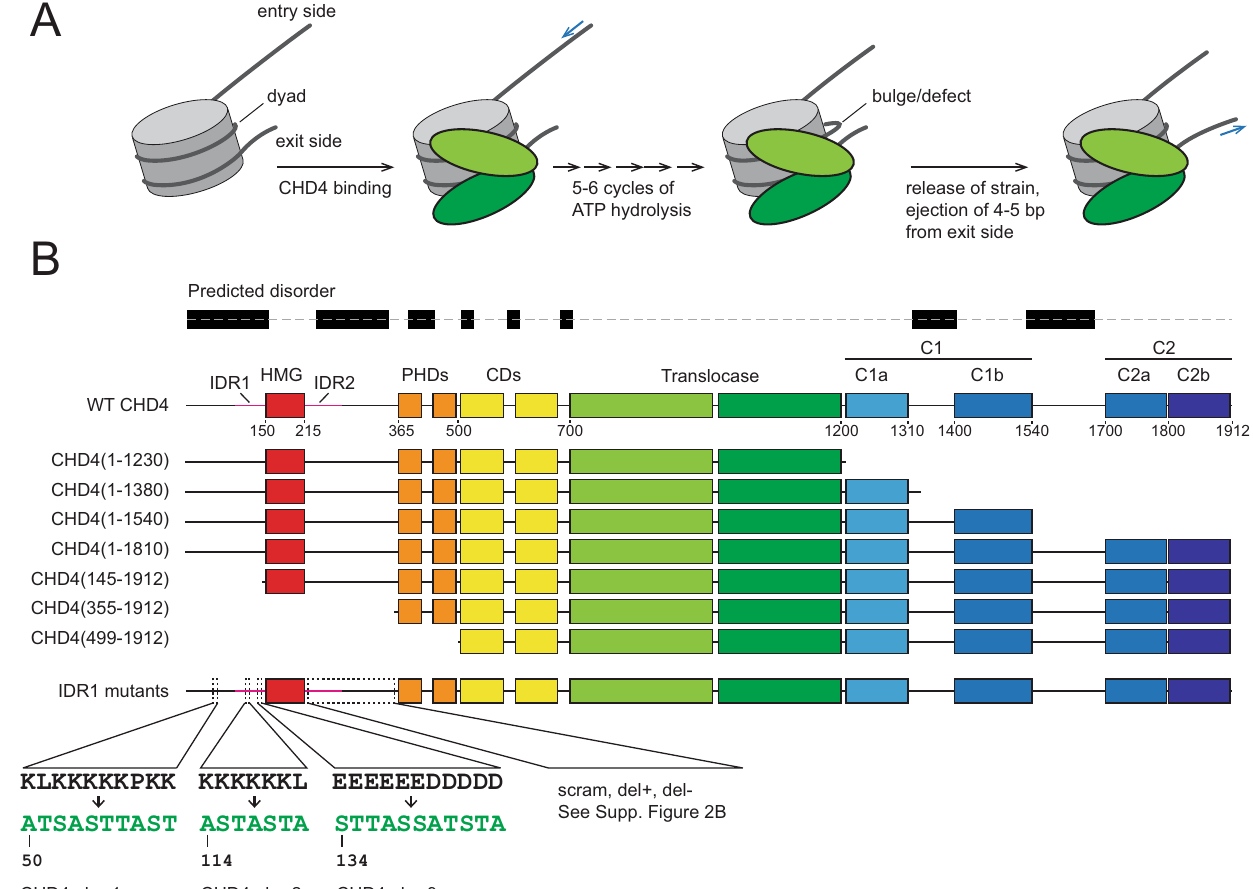
Fig. 1 | Model for CHD4-driven nucleosome sliding activity. A Model for CHD4- driven nucleosome sliding, based on previous work 4,19,80 . After initial binding of CHD4,multipleroundsofATPhydrolysisarecoupledto1-bptranslocationsofDNA from the entry side, building up a bulge or twist defect that incorporates the additionalbasepairs. This defectisresolvedby the expulsionofDNAfromthe exit side of the nucleosome. B Topology of human CHD4 (Uniprot: Q14839) and